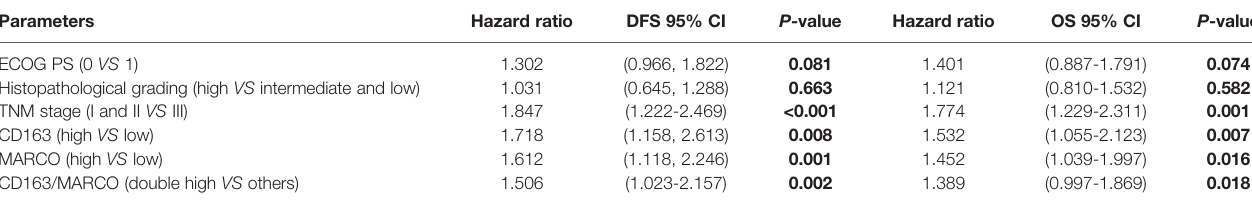
TABLE 4 | Multivariate